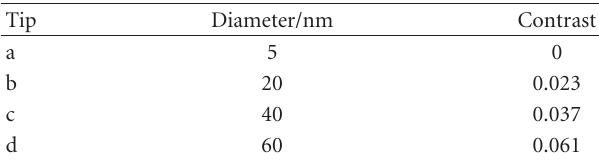
Table 1: Contrast of the probes shown in Figure 5, as calculated from